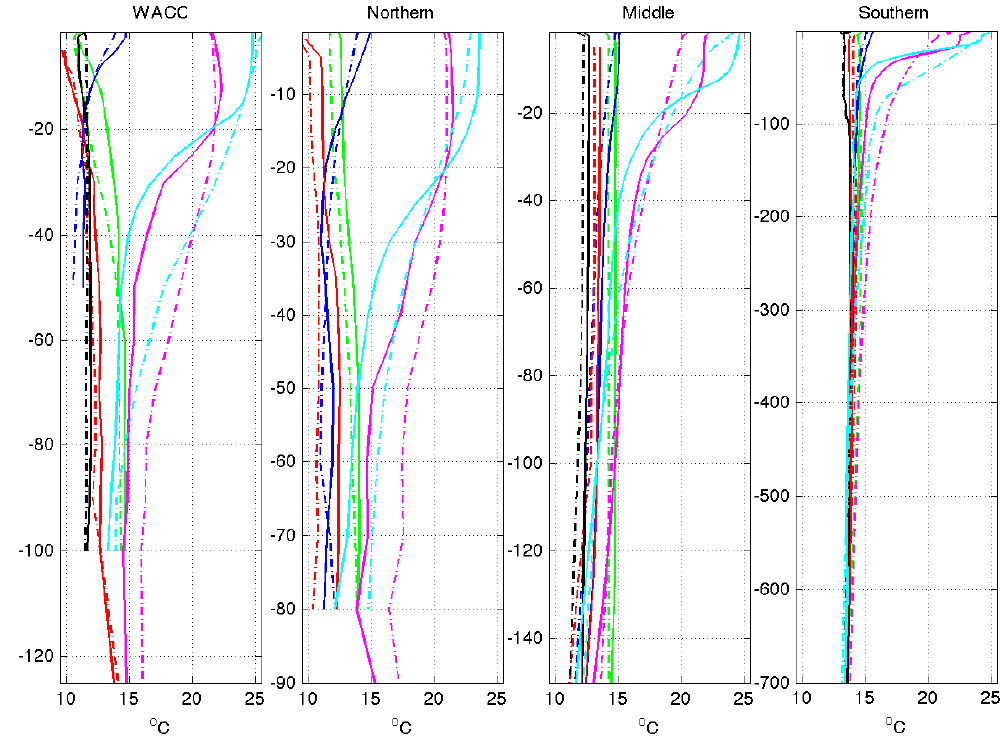
Fig. 7 Temperature Vertical profiles obtained averaging both observations (solid lines) and Fig. 7. Temperature vertical profiles obtained averaging both observations (solid lines) and corresponding model results (dashed lines) corresponding model results (dashed lines) spatially and temporally . Colours indicate different spatially and temporally . Colours indicate different cruises listed in Table 1 following Fig. cruises listed in Table.1 following Fig.01.